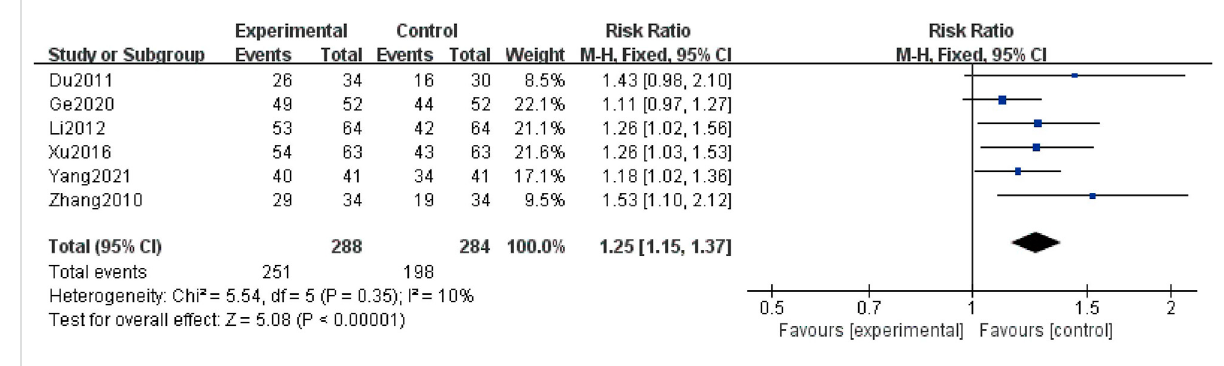
FIGURE 6 Forest plot of the clinical improvement rate.